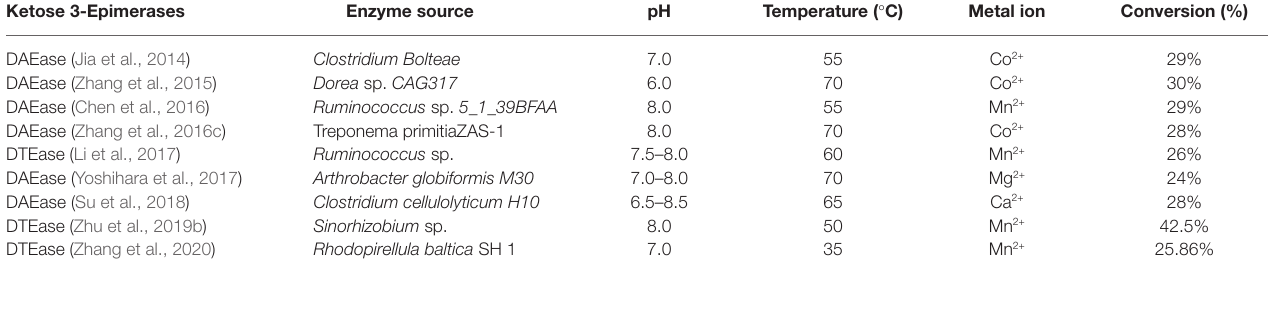
TABLE 1 | Properties of DTEase family enzymes. Ketose 3-Epimerases